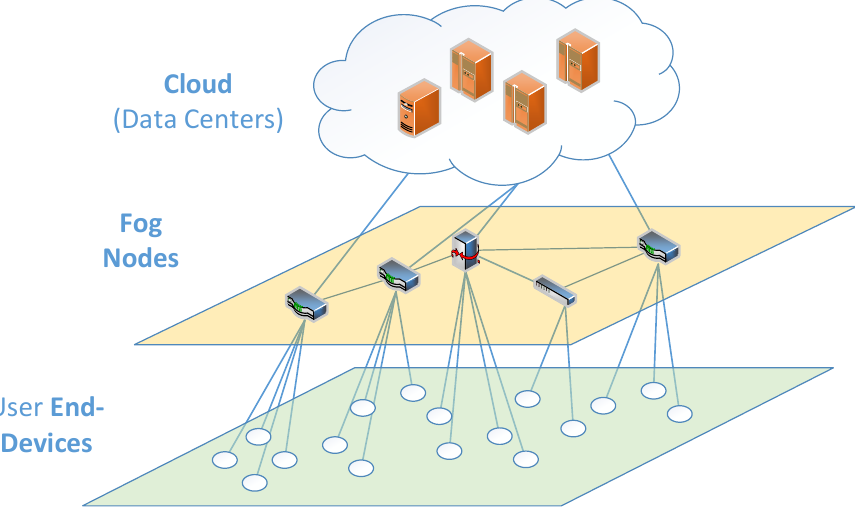
Figure 1. General Fog Computing architecture.